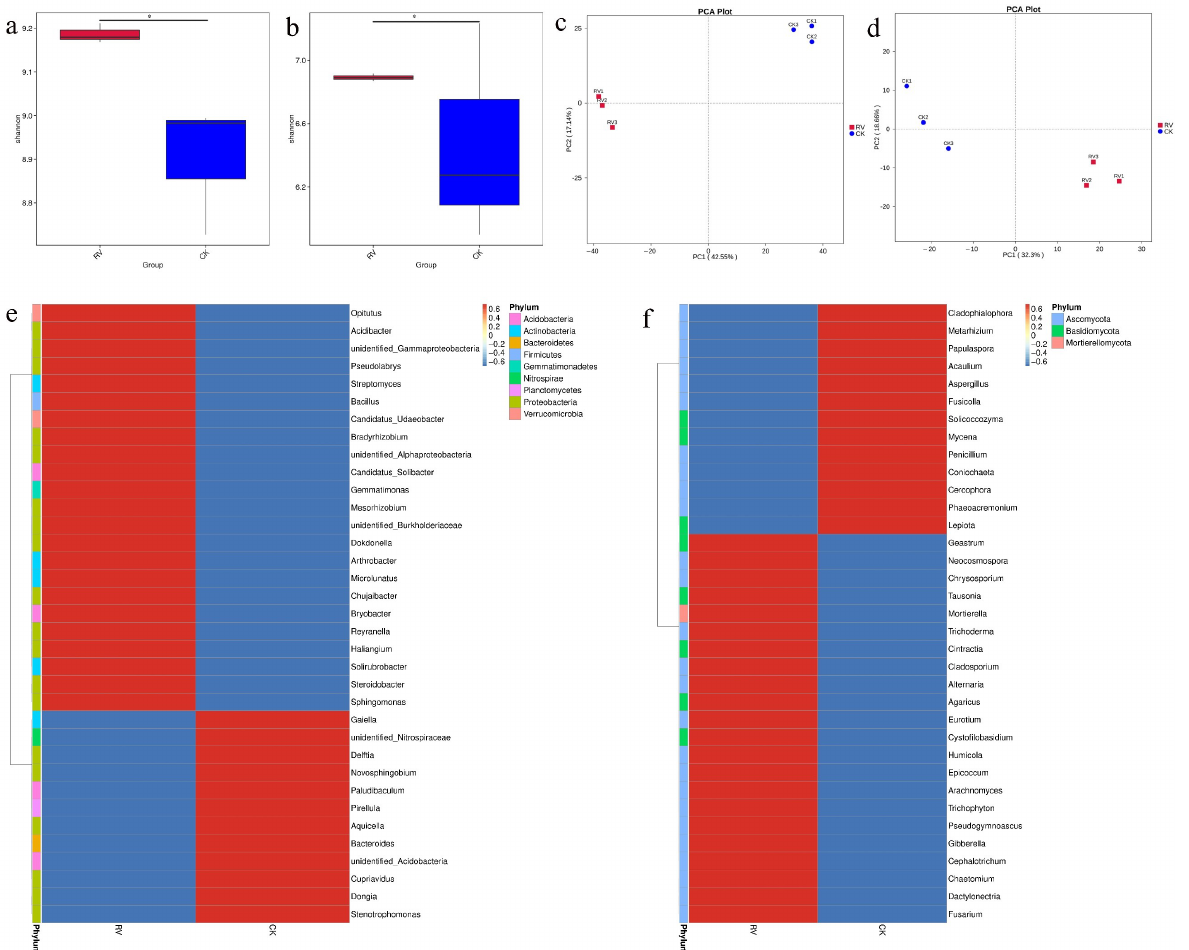
Figure 4c,d, under RV treatment, f_Mortierellaceae , o_Mortierellales , and c_Mortierellomycetes